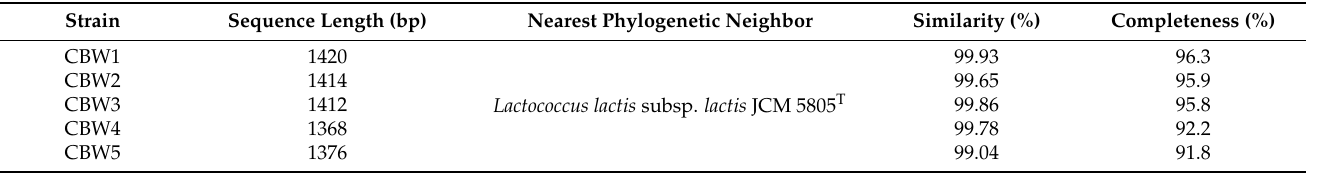
Table 4. Nearest phylogenetic neighbor of the five bacterial strains isolated from the fecal sample of a stranded Cuvier’s beaked whale according to the EzBioCloud 16S rRNA sequences